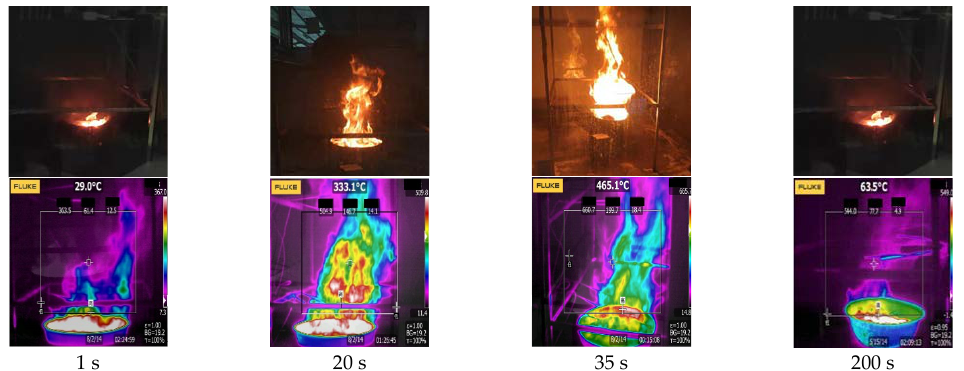
Figure 5. Thermal images of the combustion process.